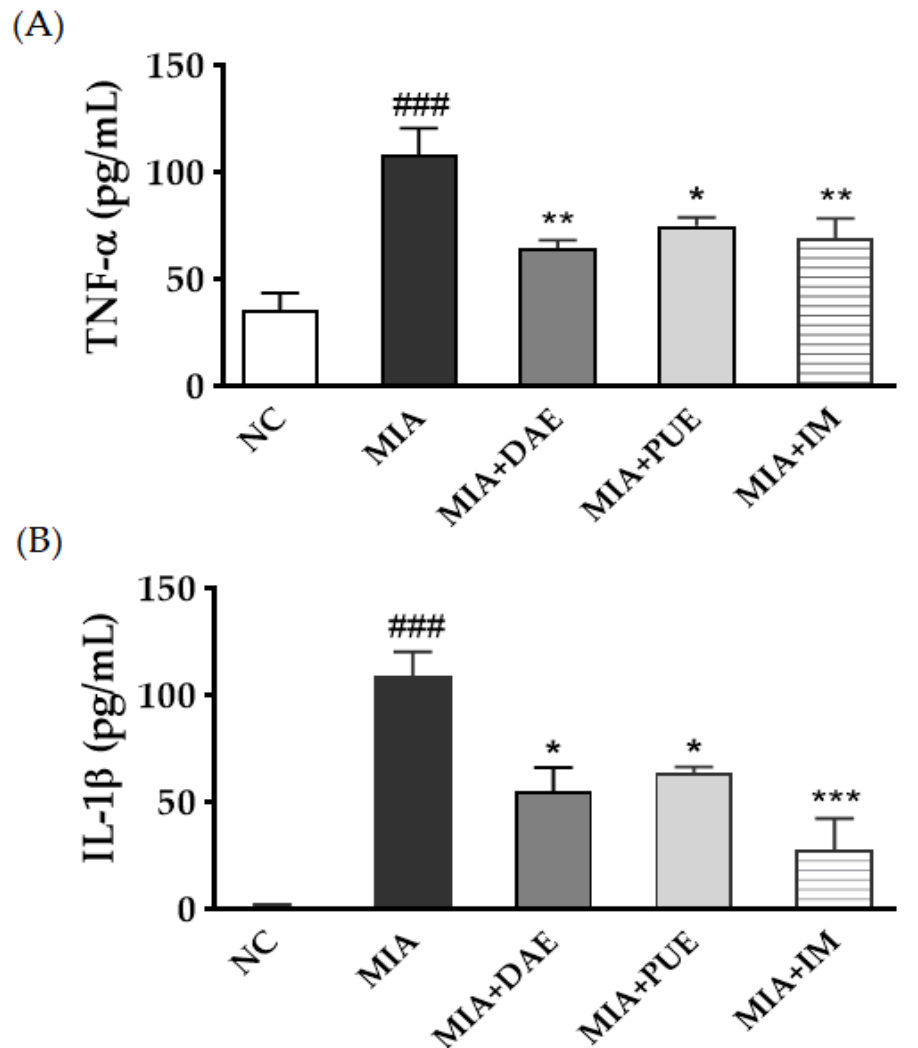
Figure 3. Effects of DAE and PUE on the serum levels of cytokines in MIA-induced OA rats. Serum cytokines including ( A ) TNF- α and ( B ) IL-1 β were quantified by ELISA. Data are expressed as the mean ± SEM ( n ≥ 3). NC, untreated; MIA, only MIA-induced; MIA + DAE, MIA-induced and DAE-treated; MIA + PUE, MIA-induced and PUE-treated; MIA + IM, MIA- induced and IM-treated rats. ### p < 0.001 indicates statistically significant differences between the NC and MIA-induced control rats. * p < 0.05, ** p < 0.01, and *** p < 0.001 indicate statistically significant differences between the MIA-induced control rats and the DAE-, PUE-, or IM-treated rats.